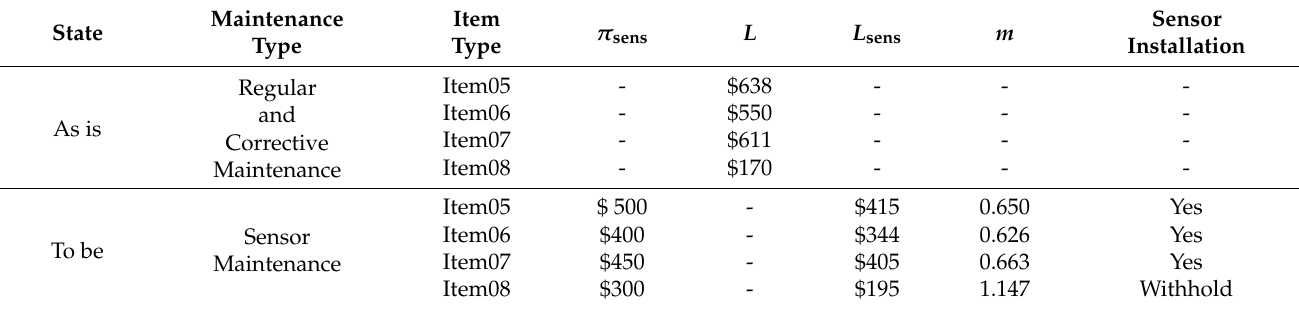
Table 5. Expected loss after installation of detection sensor: Expected loss calculation when the detection sensors are installed on Item 5 to